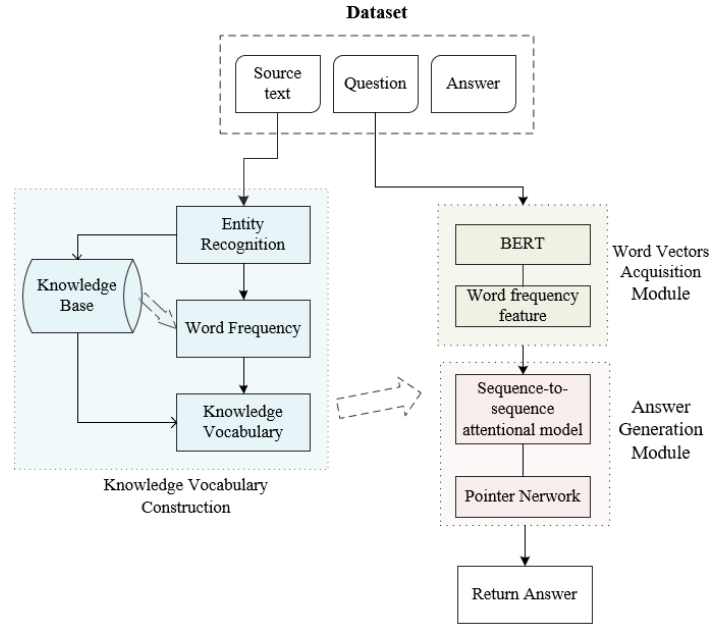
Figure 1. The realization process of this